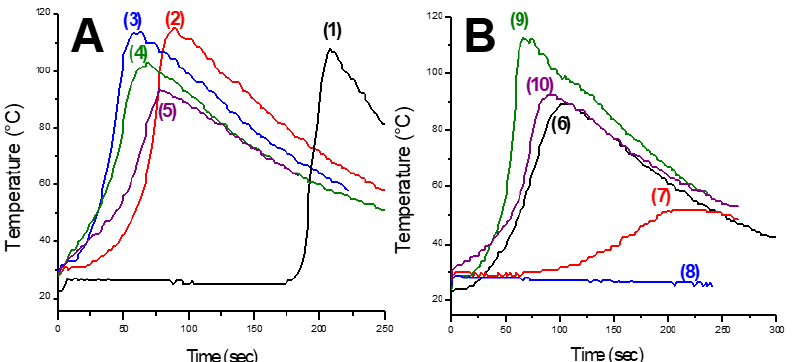
Figure 26. Chemical structures of copper complexes Cu-34 – Cu-41 .